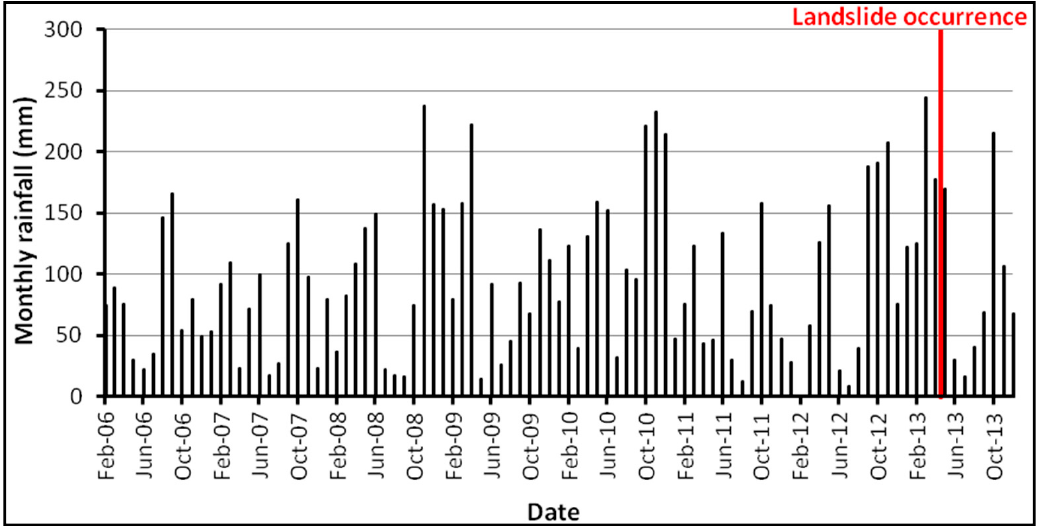
Figure 4 . Monthly rainfall in the landslide area from 2006 to 2013. Figure 4. Monthly rainfall in the landslide area from 2006 to